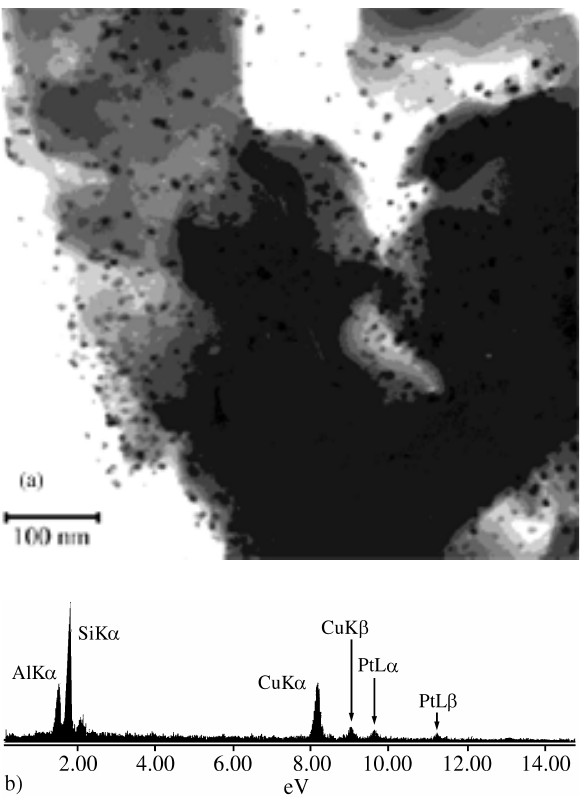
Figure 3. (a) TEM and (b) EDX analysis of 1%Pt/HUSY (sample D).